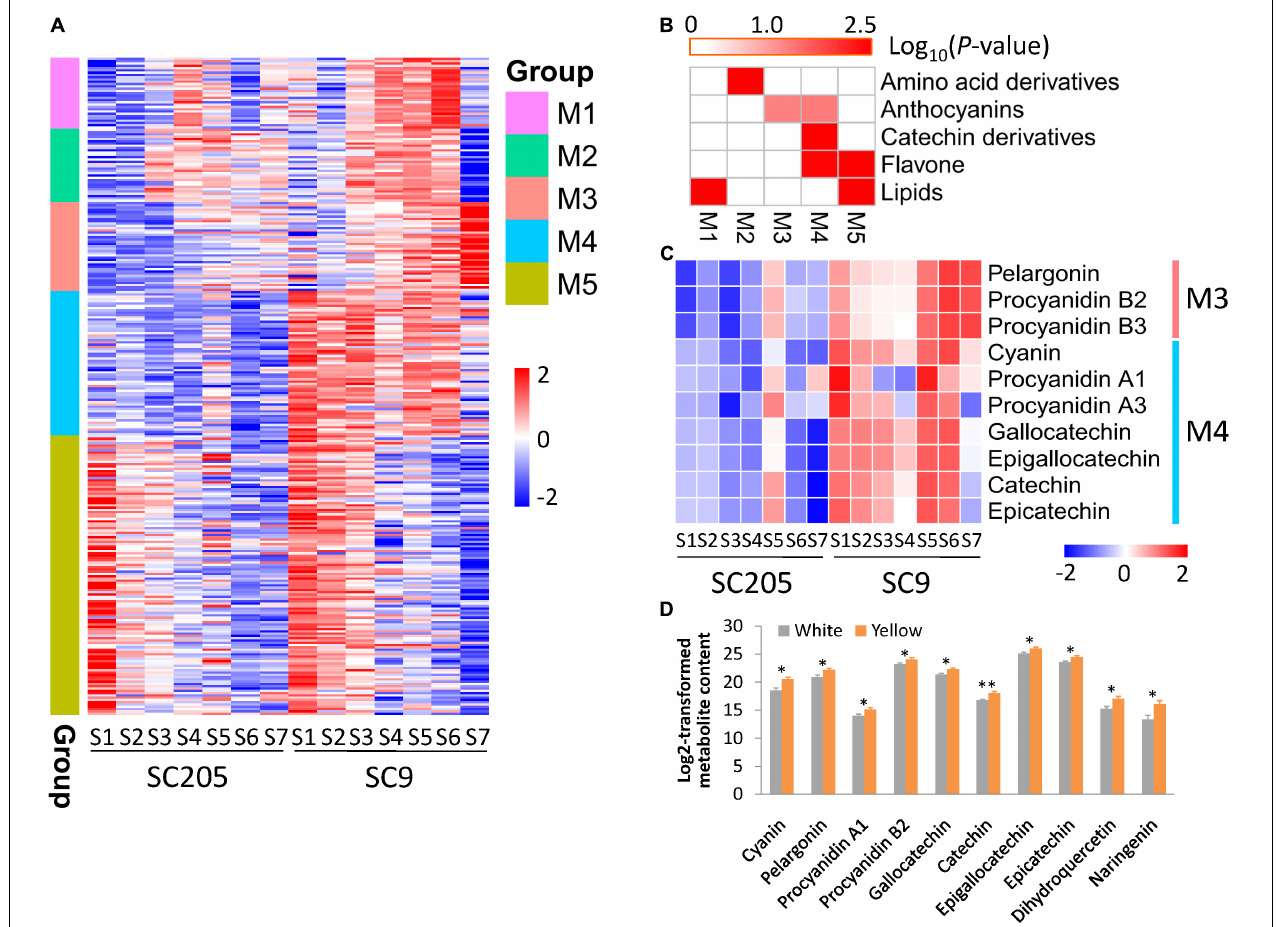
FIGURE 3 | Metabolite profiles of cassava tuberous roots with different colors during seven developmental stages. (A) Metabolite profiles of SC205 and SC9 during tuberous root development. A total of five groups (M1-M5) were determined. (B) Metabolite enrichment analysis of the groups presented in panel (A) . (C) Changes of metabolites relevant to anthocyanins and catechin derivatives during tuberous root development. (D) DAMs identified between five white-rooted and five yellow-rooted cassava accessions at the developmental stage S7 with at least two biological replicates. The values represent the mean ± SD, and ∗∗ and ∗ represent significant differences at P < 0.01 and P < 0.05, respectively, based on the Student’s t -test.